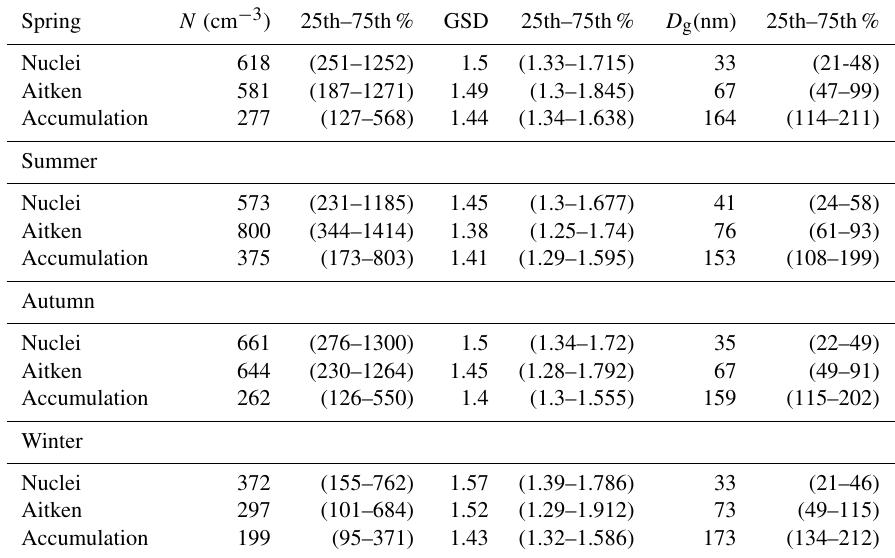
Table 1. Statistics of modal fits per season. Table shows statistics derived from fitted hourly number size distributions. Indicated in the table are Nuclei, Aitken and accumulation mode parameters as the median and 25th–75th percentiles. GSD represents the geometric standard deviation and D g the geometric mean diameter of each of the log-normal